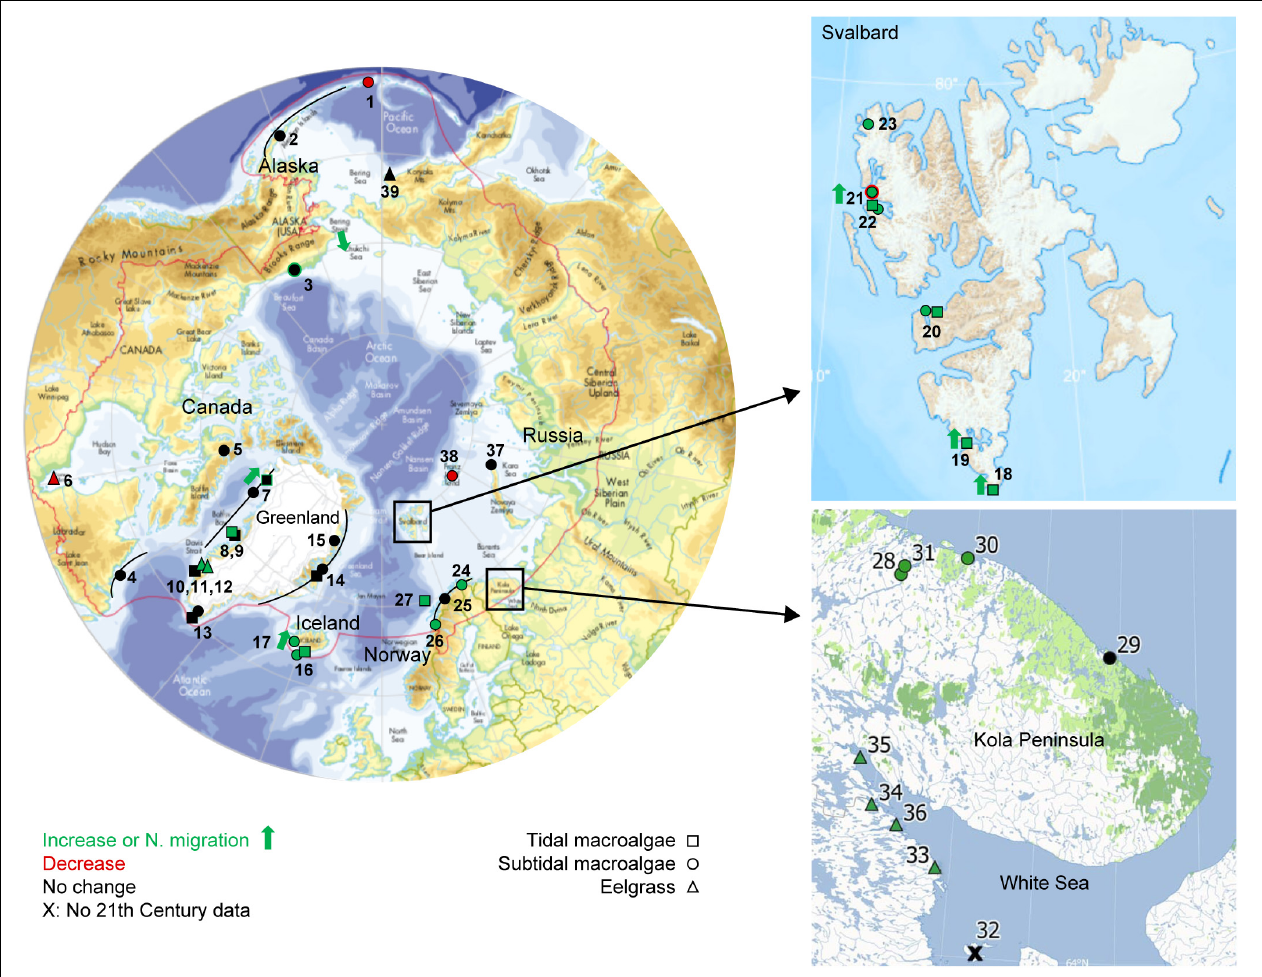
FIGURE 1 | Overview of compiled studies on pan-Arctic marine vegetation trends spanning at least 10 years and entering into the 21th Century. Trends are marked as increasing (green), declining (red) or no change (black) for subtidal macroalgae (circles), intertidal macroalgae (squares), and eelgrass (triangles). Northward migration is indicated by green arrow. If the site represents trends for more than one period, only the most recent is shown, and if this did not include the 21th Century, the site is marked by X. A line through a circle/square indicates that there are several sites along a gradient. The red line defines the Arctic region based on the Arctic Council definition (Huntington, 2001). Numbers refer to sites specified in Table 1 . Close-up of study sites in Svalbard and Russian Barents Sea/White Sea. Main map from Huntington, 2001, Svalbard map from Norwegian Polar